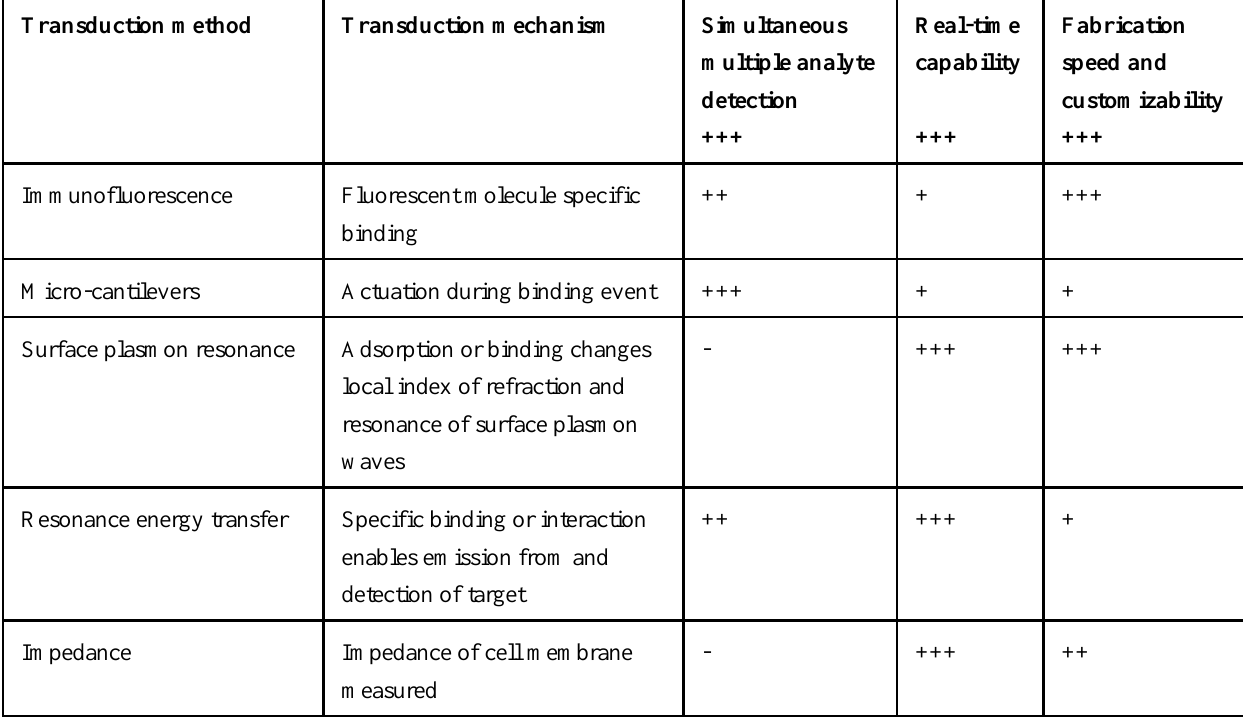
Table 1. Selected transduction methods and rated performance measurements for